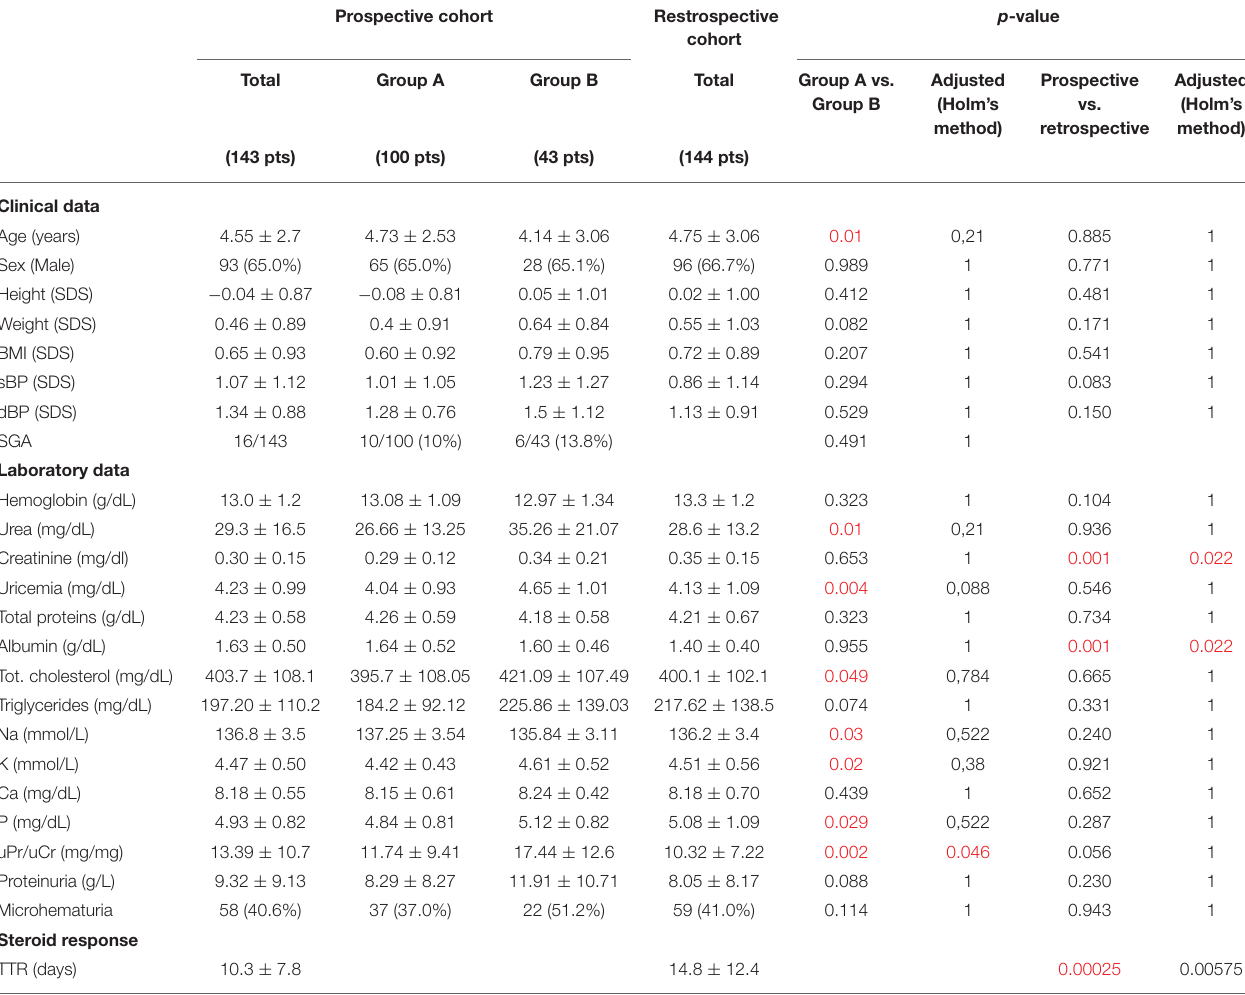
TABLE 1 | Comparison of clinical and laboratory data at onset: Group A vs. Group B and prospective vs. retrospective cohort.